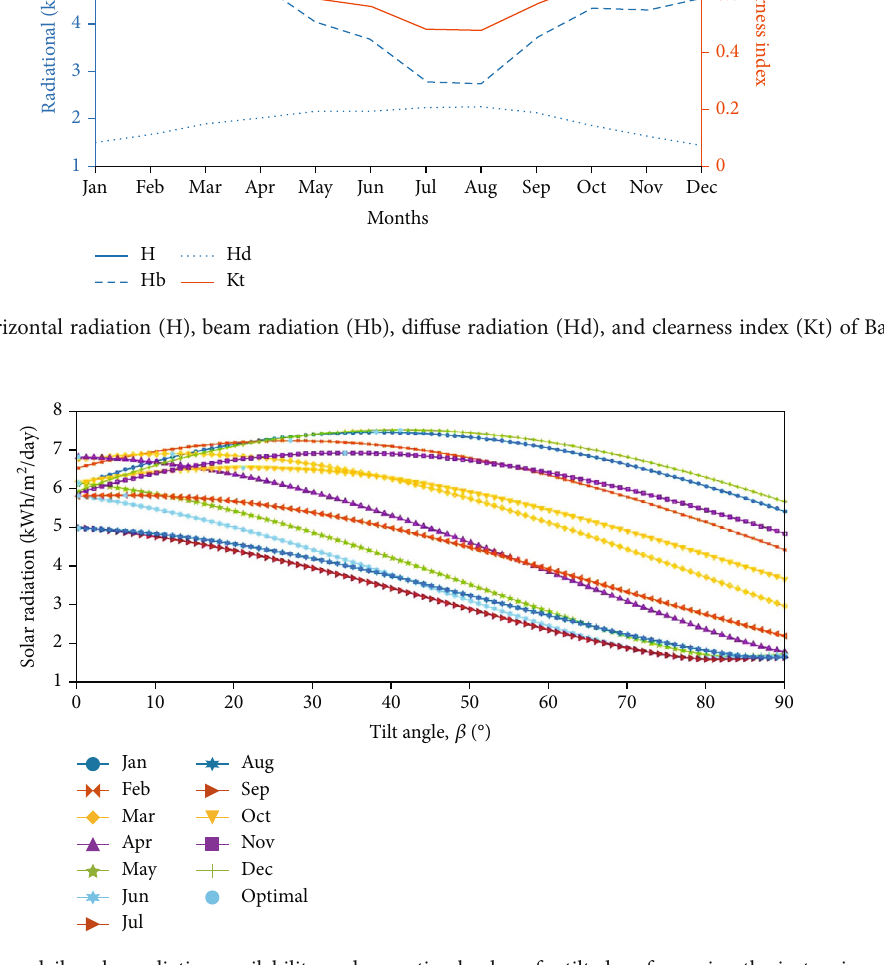
Figure 4: Monthly average daily solar radiation availability and an optimal value of a tilted surface using the isotropic model of equation (16), Bahir Dar